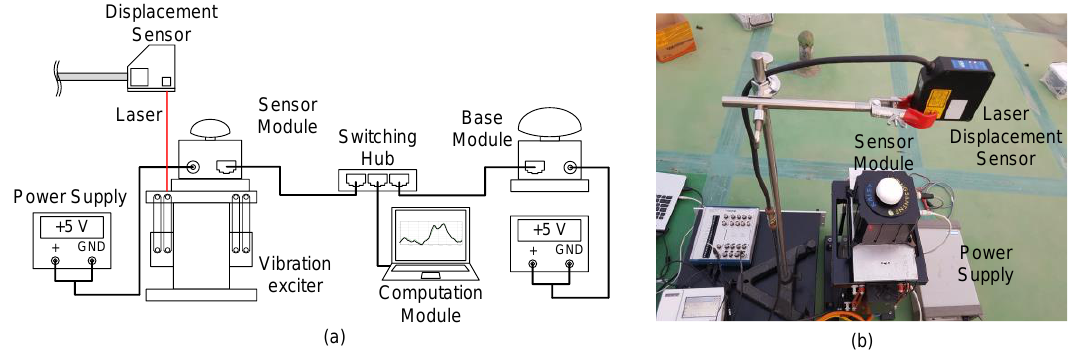
Figure 8. Overview of the lab-scale experiment: ( a ) experiment configuration and; ( b ) sensor module installation.